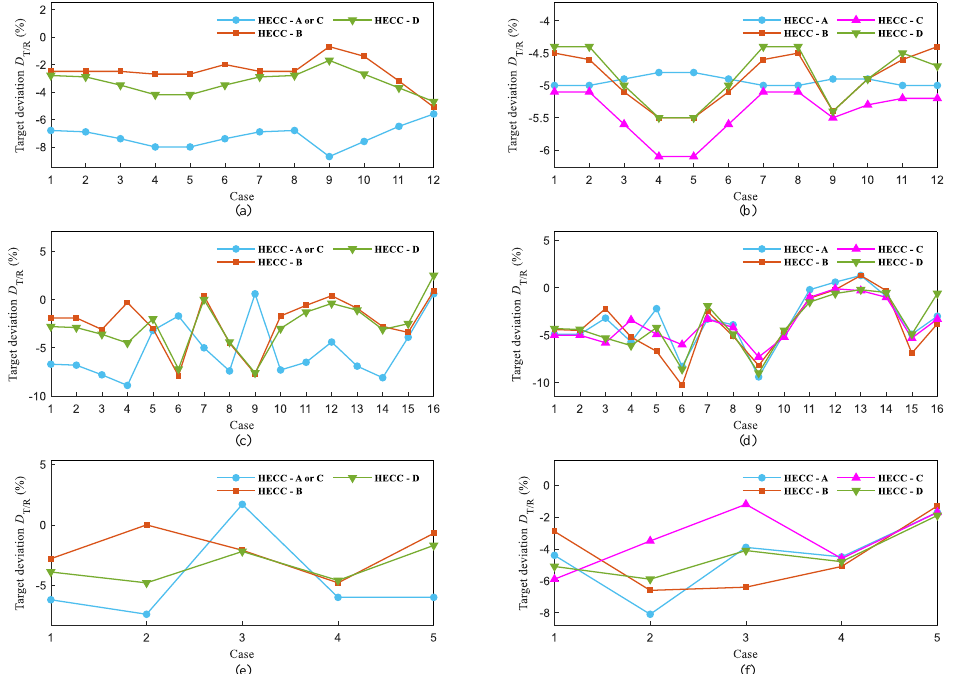
14 of 26 Figure 2. Target deviations for cases in three types of numerical experiments: ( a , b ) cases for the first type without and with maximum area limitations; ( c , d ) cases for the second type without and with maximum area limitations; ( e , f ) cases for the third type without and with maximum area limitations. 4.3. Analysis and Improvement of the General ESPA Method The deviation amplitude reduction is addressed first, and then a measure is sug- gested to make the target deviation tend to zero. 4.3.1. Measure for Enhancing Stability The poor stability of target deviation was mainly caused by target deviations of 13.5% and 8.2%, which occurred in case 8 of the second numerical experiment and case 4 of the third numerical experiment. By adjusting criteria to make the parameter RT cc (A), v ( ij ), wr